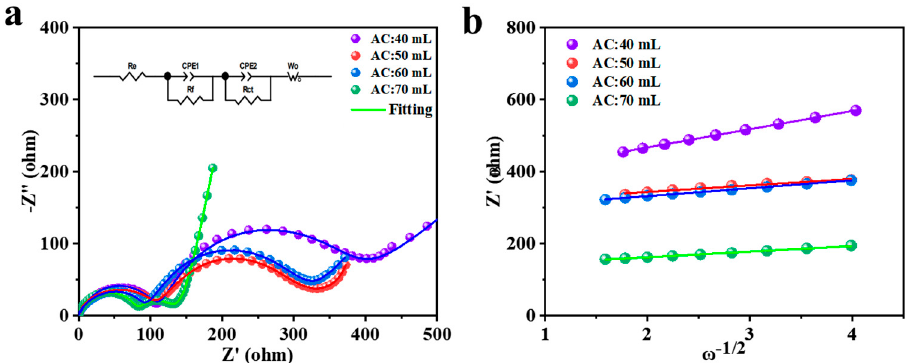
Figure 6. ( a ) Nyquist plots and corresponding equivalent circuit model of NCM622 from different ammonia content. ( b ) the relationships between Z’ and ω − 1/2 based on ( a ). Table 6. The fitting values of R f and R ct and the calculated values of D Li+ of the as-prepared samples.